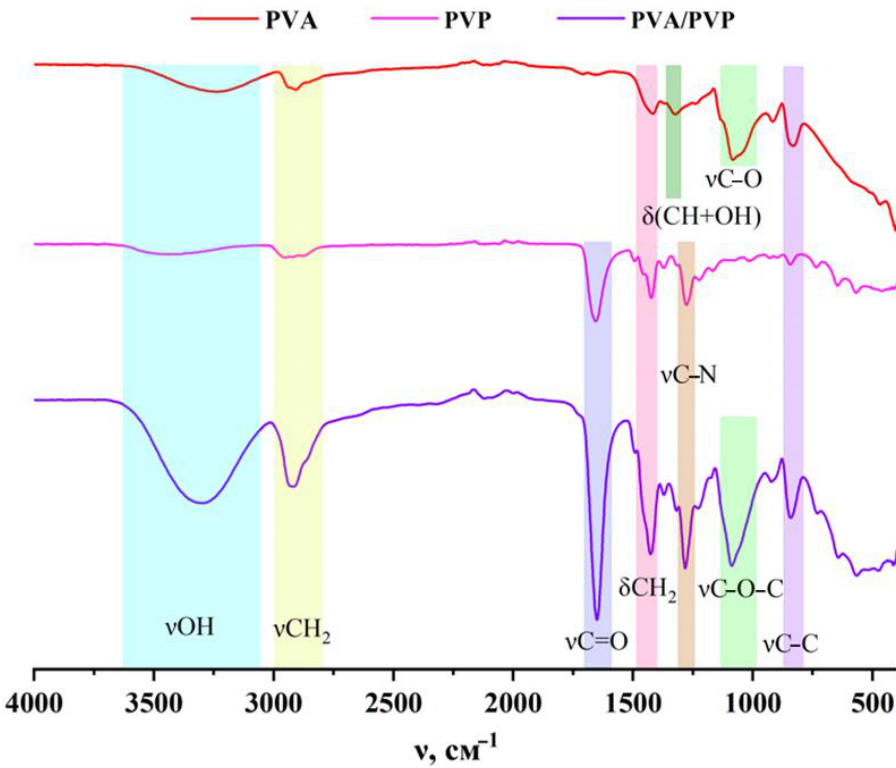
Figure 3. IR-spectrum of the 5% aqueous solutions of PVA, PVP, and PVA/PVP. The participation of the hydroxyl group in the formation of intermolecular hydrogen bonds is manifested through the shift of the absorption band towards lower frequencies and a significant increase in its intensity [51]. The absorption band of the PVA hydroxyl group at 3343 cm −1 shifts towards lower wave numbers at 3313 cm −1 for the PVA/PVP mixture due to the formation of an intermolecular hydrogen bond between the PVP car- bonyl group and the PVA hydroxyl group [40]. At the same time, a slight shift of the ab- sorption band of the electron donor group by 10 – 20 cm −1 is characteristic [51]; therefore, the PVP carbonyl band group is shifted from 1656 cm −1 to 1649 cm −1 . The IR spectra peculiarity of CaP is the presence of two doubled absorption bands.